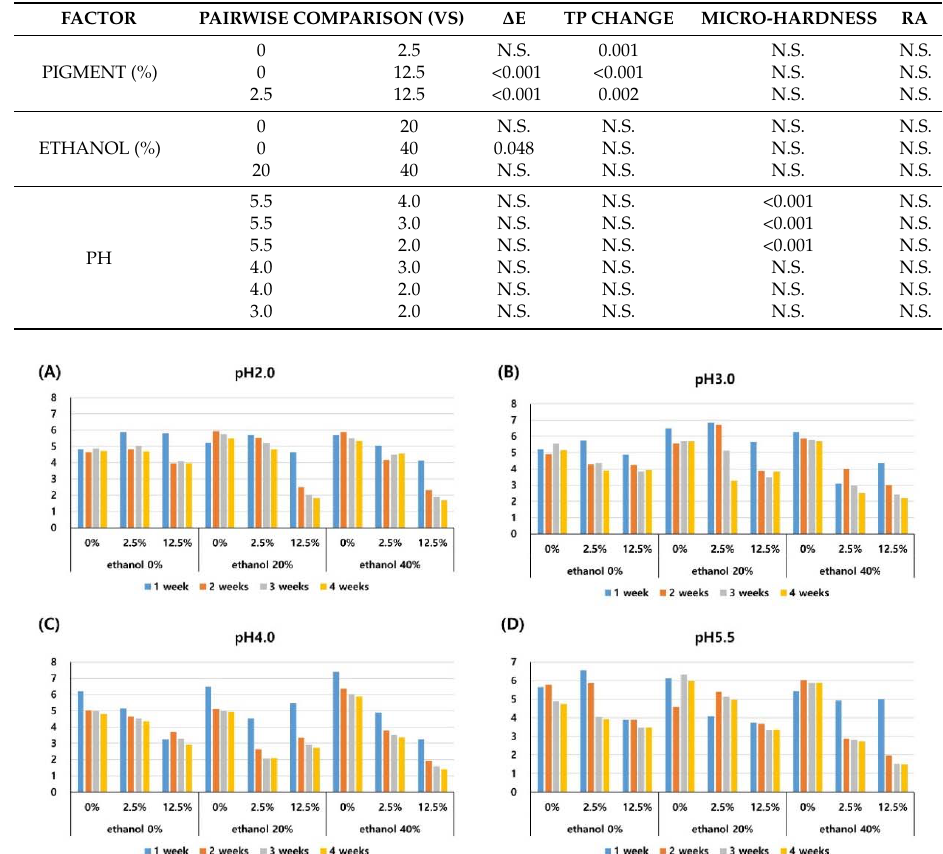
Figure 3. Mean translucency parameters of the composite resin after different periods of storage (1-, 2-, 3-, and 4-weeks) in media of pH 2.0 ( A ), pH 3.0 ( B ), pH 4.0 ( C ), pH 5.5 ( D ) with three different pigment concentrations (0%, 2.5%, 12.5%), and three different ethanol concentrations (0%, 20%, 40%).